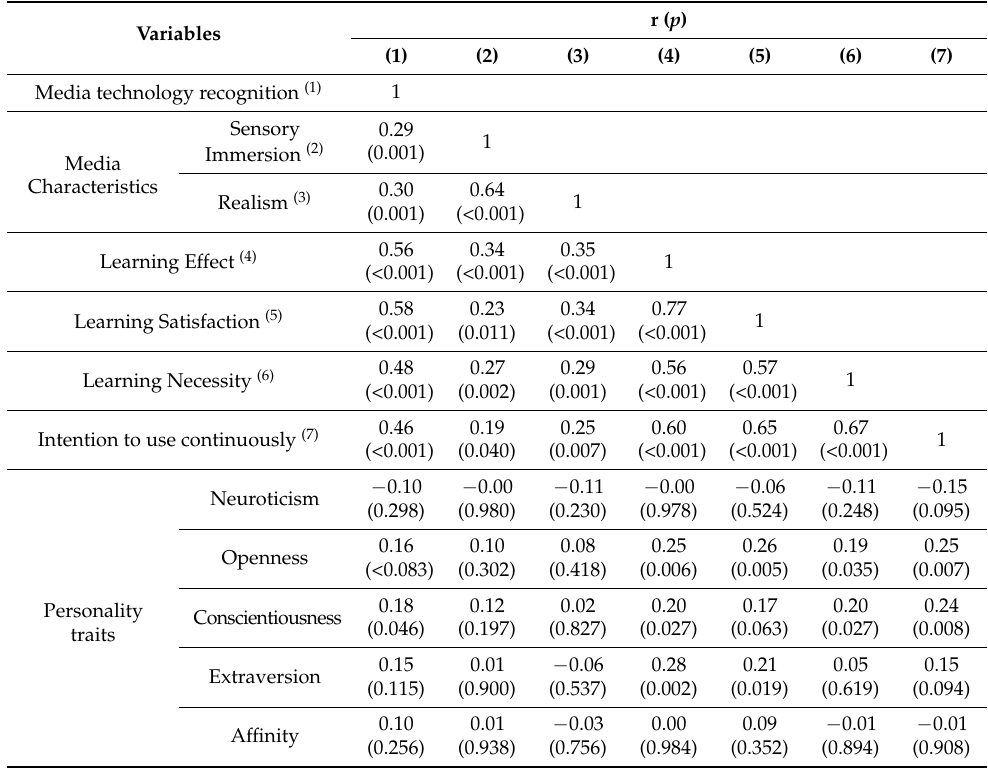
Table 4. Relationship between the learning effects of virtual reality media and the study’s parameters.